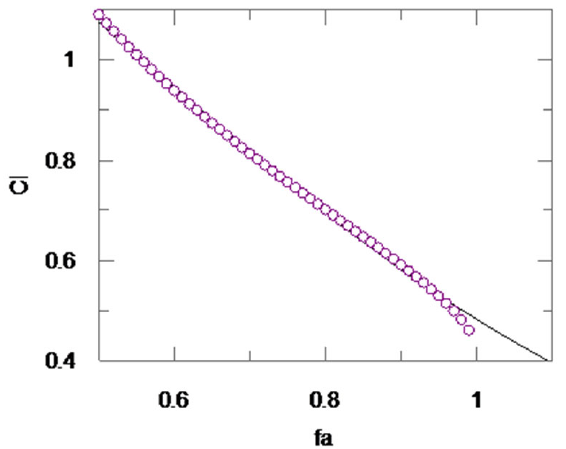
Figure 4. Computer-generated graphical presentation of the combination index ( CI ) vs. the fraction affected (f a ), i.e., the effect of reduction of rhodesain activity exerted by a mixture of CD24 –curcumin (molar ratio 1:62).